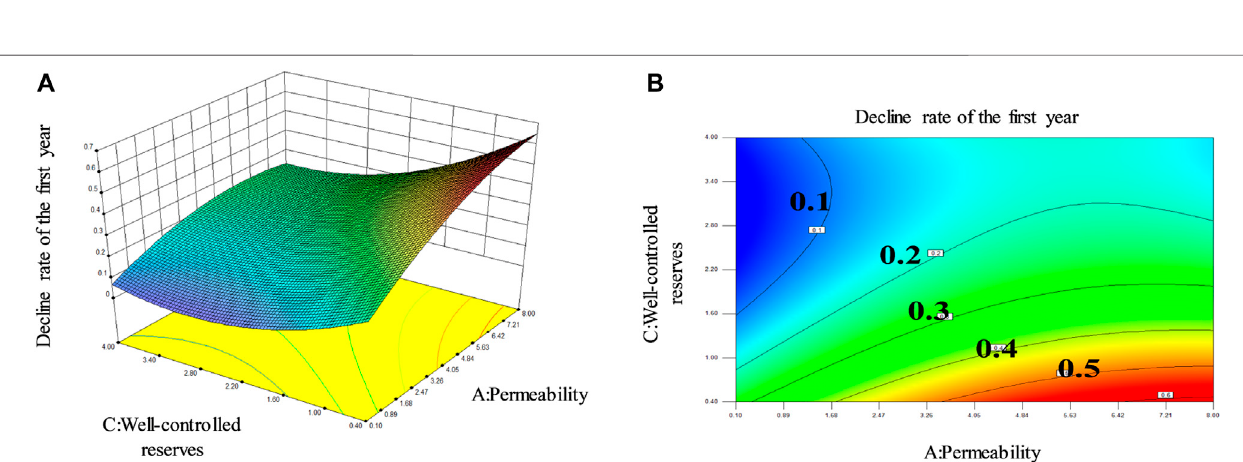
Frontiers in Physics |